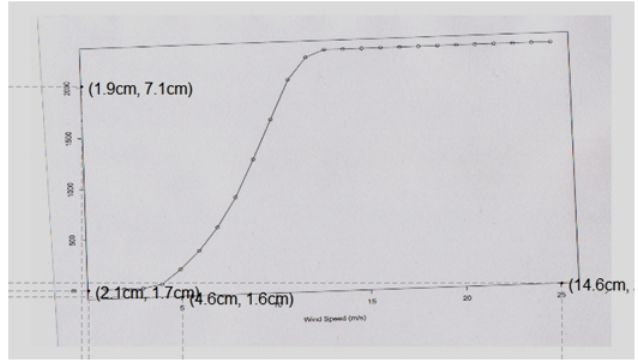
Figure A2. Selection and mapping of two points on each X- and